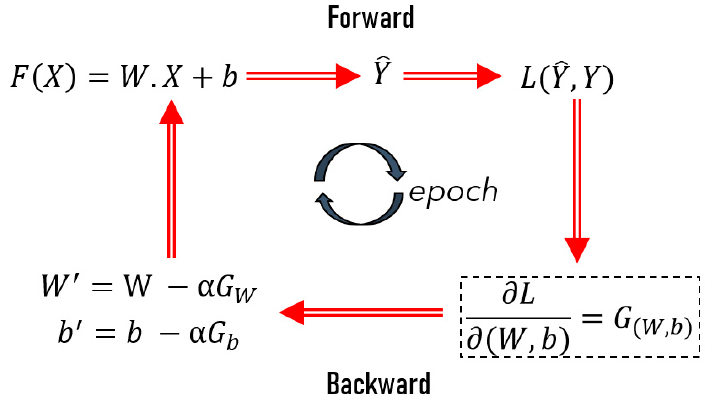
Figure 2. The overall workflow of a CNN.